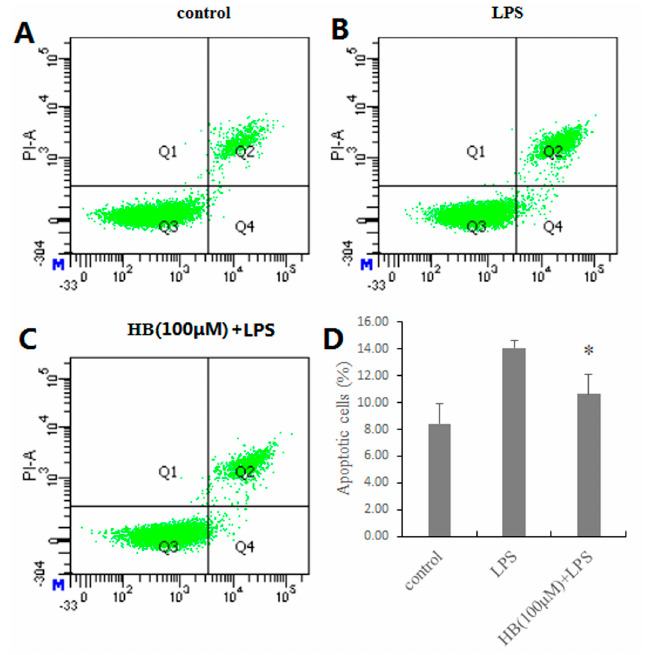
Figure 6. Effects of HB on LPS-induced apoptosis in RAW 264.7 Cells measured by flow cytometry. ( A ) Control ( B ) LPS (1 μ g/mL) ( C ) RAW 264.7 Cells were pretreated with 100 μ M HB for 1 h before